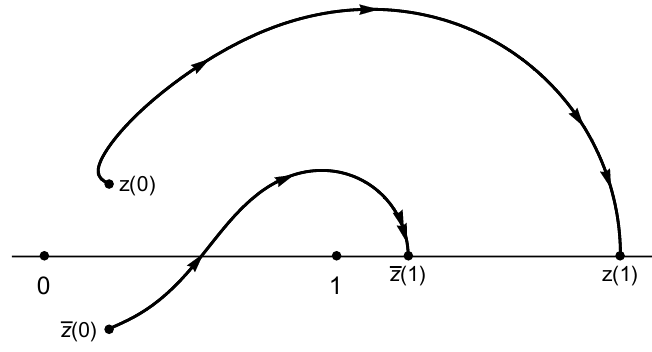
Figure 5.6: The plot of z , ¯ z -curves of the Regge kinematics.